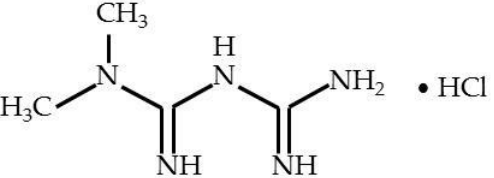
Figure 1. Chemical structure of metformin hydrochloride (M-HCl).